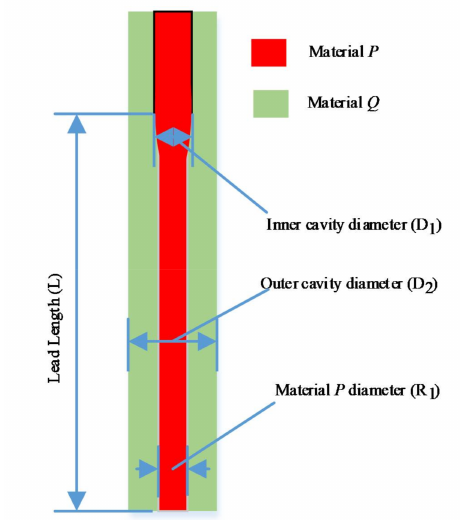
Figure 3. The evaluation index of 3D printing